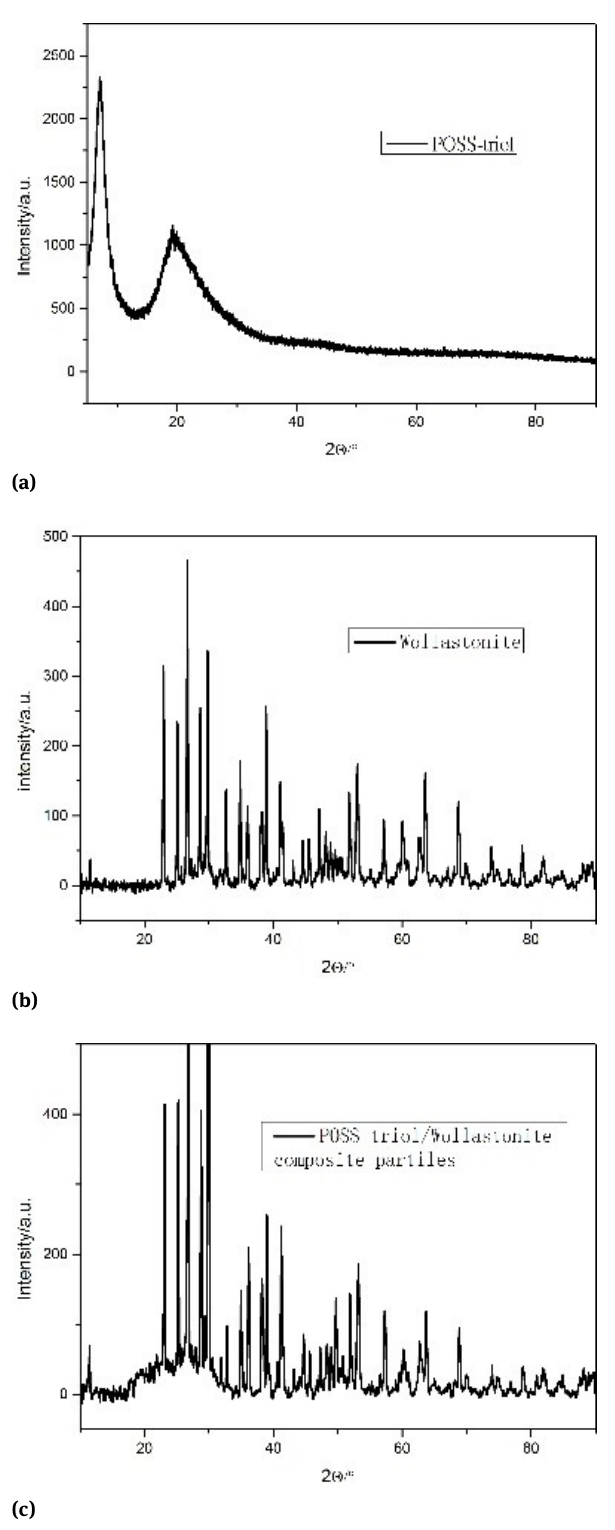
Figure 9: XRD spectra of wollastonite and its composite particles